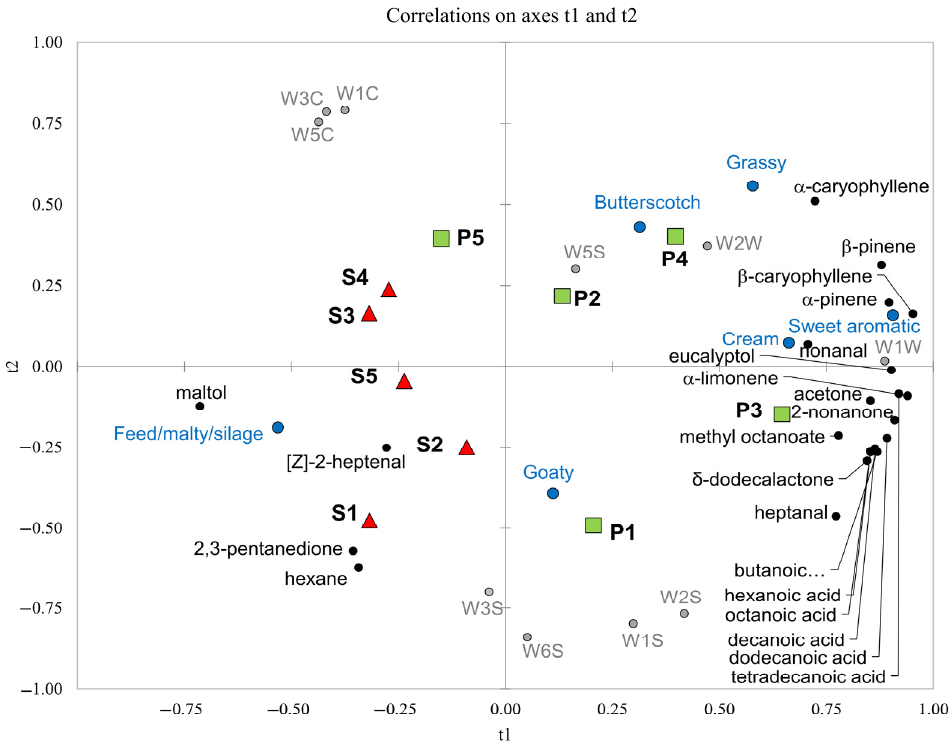
Figure 4. PLS-loading plot (t1 vs. t2) for volatile organic compounds (black circle), E-nose sensors (grey circle) and olfactory sensory descriptors (blue circle) of Pasture goat’s milk (P; green square) and Stall goat’s milk (S; red triangle). Numbers 1 to 5 indicate the milking period (April 2021 to June 2021).